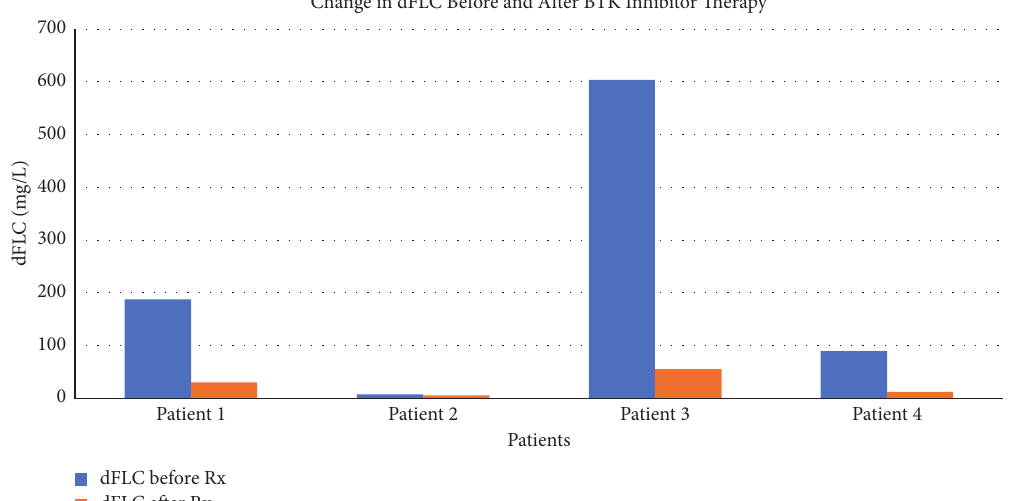
Figure 1: Change in difference of free light chains before and after BTK inhibitor therapy. dFLC: difference in free light chain and Rx: